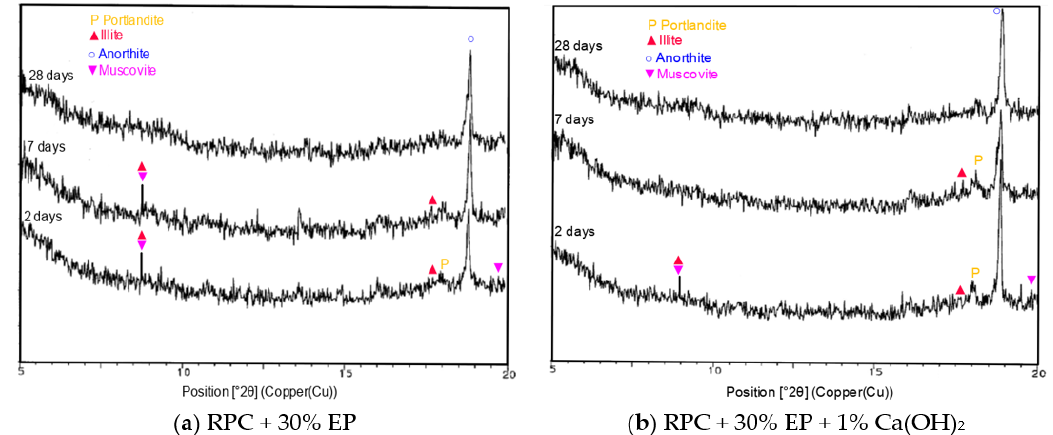
Figure 16. XRD patterns: ( a ) RPC +30% EP after 2, 7, and 28 days of curing, ( b ) RPC + 30% EP + 1% Ca(OH) 2 after 2, 7, and 28 days of curing.